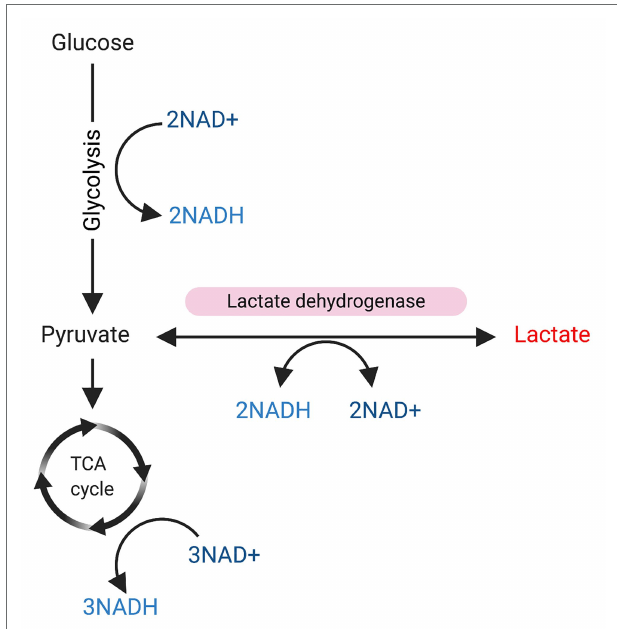
FIGURE 2 | Glycolysis and sources of NAD/NADH+. Glucose is used as a substrate for glycolysis. During glycolysis 2 NAD+ will be converted to NADH, and pyruvate will be produced. Pyruvate can be used as substrate for the tricarboxylic acid (TCA) cycle, resulting in the conversion of 3NAD+ into NADH. On the other hand, pyruvate can be also converted into lactate in a reaction mediated by lactate dehydrogenase, which converts 2NADH to